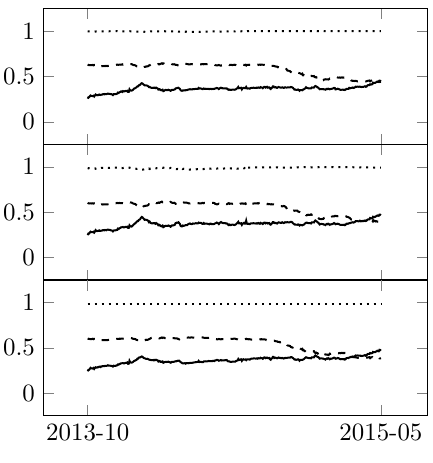
Figure 10: CDX.NA.IG.21 time series of Gaussian mixture parameters. Displaysthecalibrated w (plain), ρ 1 (dashed),and ρ 2 (dotted).Threeparametersets: θ 1 = ( w , ρ 1 , ρ 2 )withBeta-binomialrecovery (top), θ 2 = ( w , ρ 1 , ρ 2 ) with zero recovery (middle) and θ 2 = ( w , ρ 1 , 0.99) with zero recovery